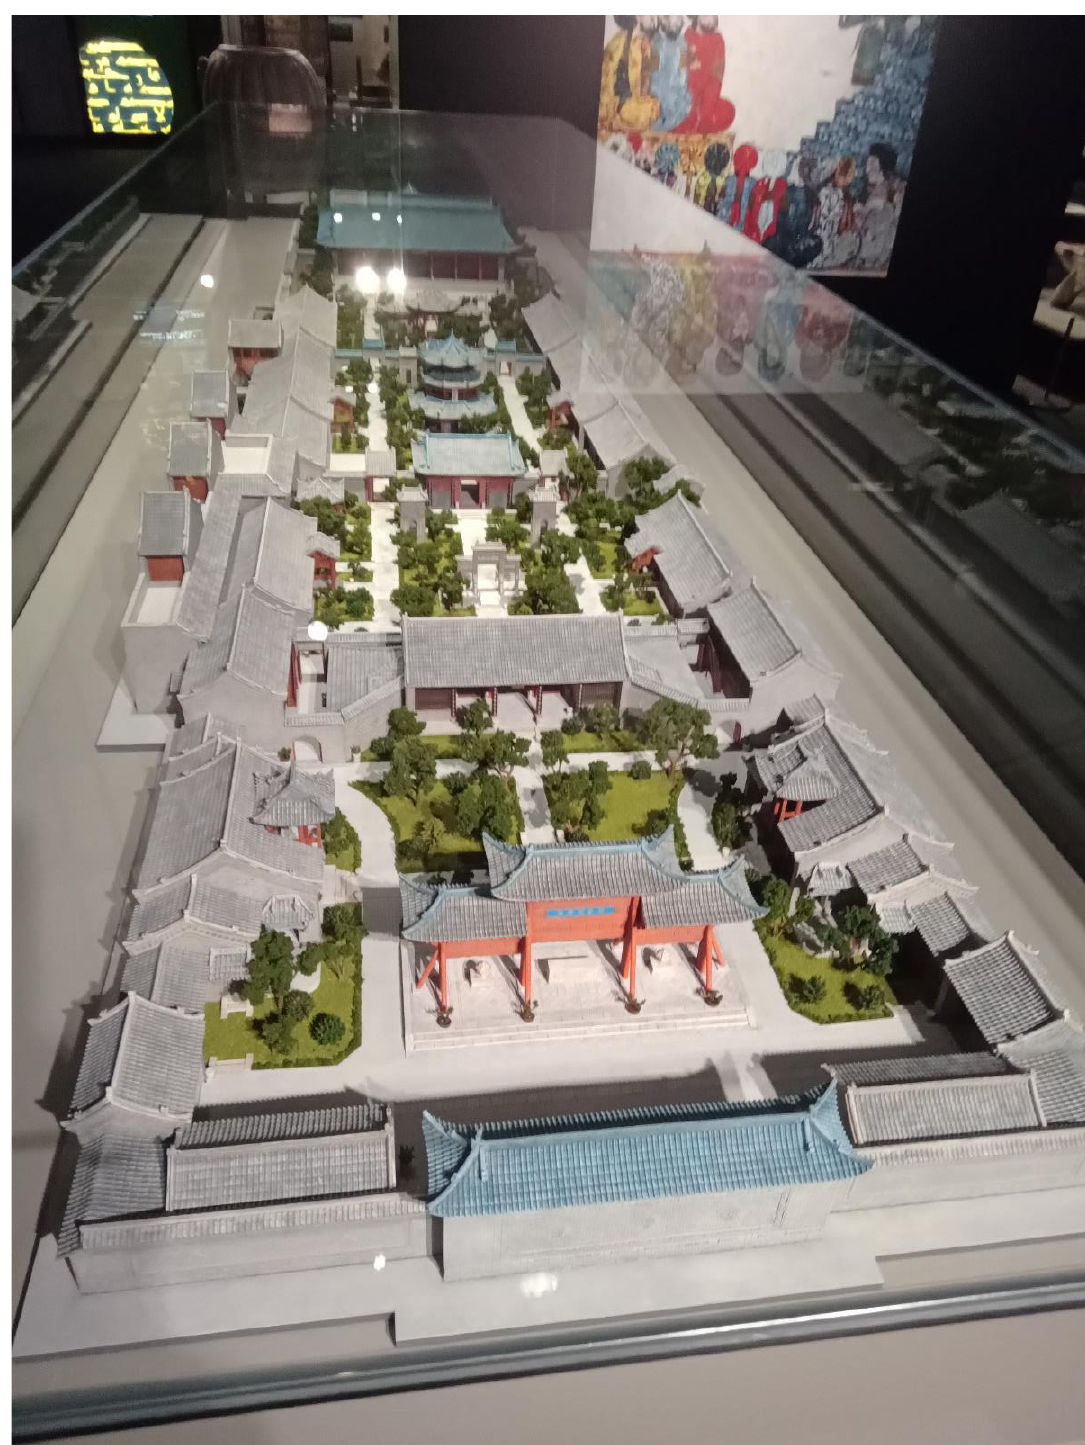
Figure 21. The collection of Islamic art in the King Abdulaziz Center for World Culture (Ithra), Dhahran, Saudi Arabia. Model of mosque in Xinjian, China. Photo of the author.